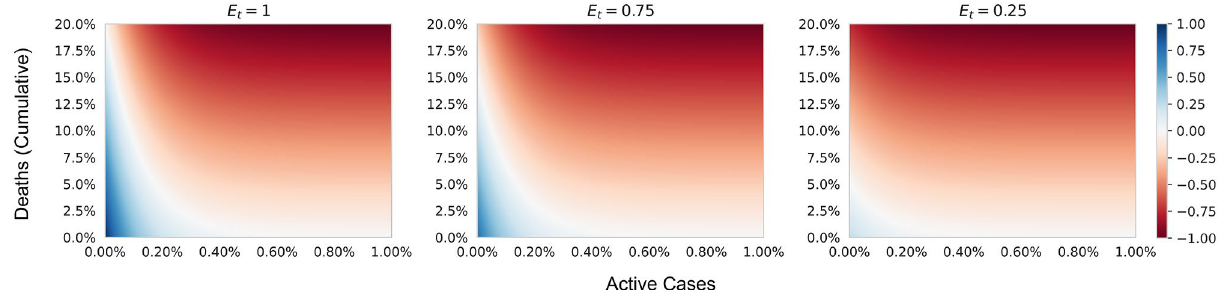
Figure 4. A heatmap representation of the reward function. The horizontal axis represents the percentage of active cases. The vertical axis represents the cumulative death percentage. From left to right, the three heatmaps illustrate the reward distribution in level-0 movement restriction, level-1 movement restriction, and level-2 movement restriction, respectively. In the three restriction levels 0, 1, and 2, the value of E t is expected to be approximately 1, 0.75, and 0.25, respectively.